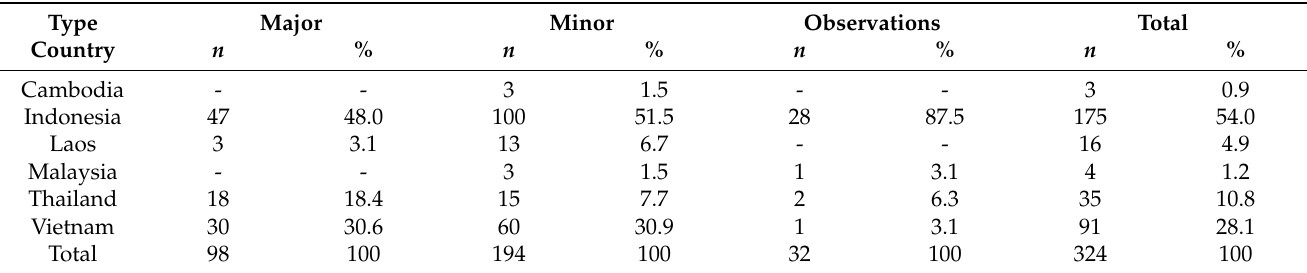
Table 4. Number of major and minor corrective actions required, and observations in the Southeast Asian